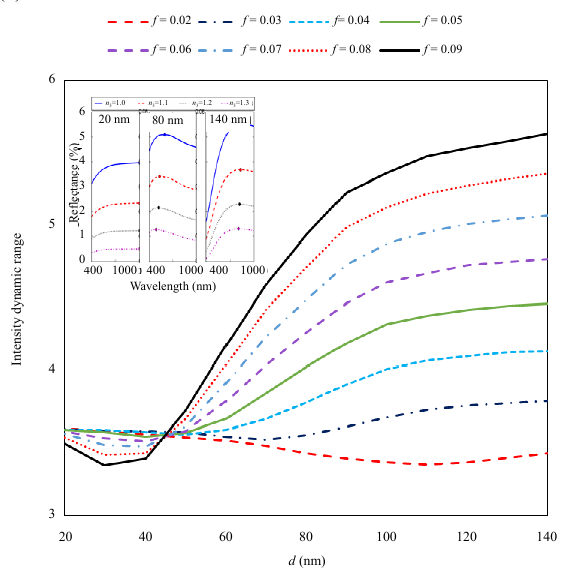
Fig. 7 Intensity dynamic range as the function of film thickness d at different values of filling factor, f , for Ni NPs in polymer ( n h =1.466). The inset shows the calculated reflection spectrum for Ni NPs in polymer with f = 0.05 at the film thicknesses of 20 nm, 80 nm, and 140 nm for different values of n 3